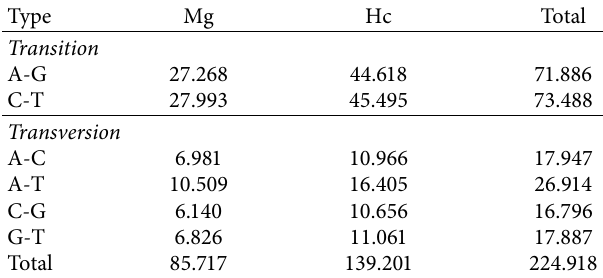
Figure 7: Venn diagram depicting the results of KEGG immune pathway analysis. Table 2: Distribution of different single-nucleotide polymorphism types between the different